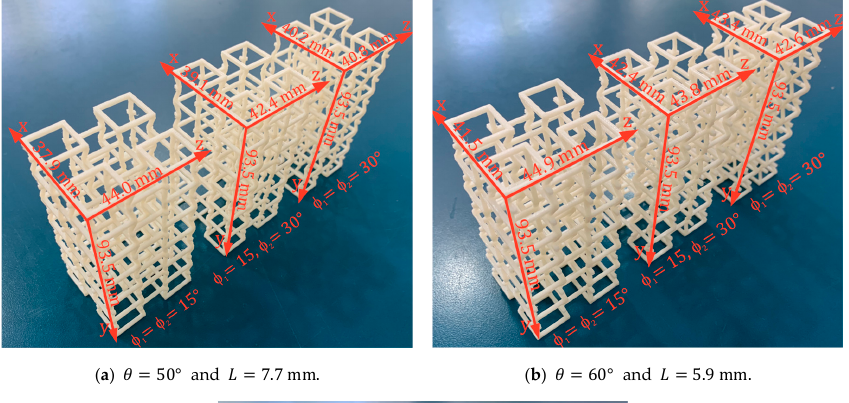
Figure 7. Experimental setup to measure the transverse deformations of structures using an image correlation system through a Basler ace Aca 1300 − 200 uc camera. Additionally, three ‐ point bending experiments were carried out at a speed of 1 𝑚𝑚 / 𝑚𝑖𝑛 . To compare the bending stiffness of each structure, the experiments were car ‐ ried out with a distance between supports equivalent to the length of 4 ‐ unit cells. To study the mechanical behavior that this new structure can experience, three groups of macro ‐ structures of 24 ‐ unit cells were manufactured (cid:4666) 2 (cid:3400) 2 (cid:3400) 6 (cid:4667) under different values for re ‐ entrant angle 𝜃 (cid:3404) (cid:4668) 50°;60°;70° (cid:4669) . Using the same geometric configurations as above, within each group, three samples were manufactured with different values for the angle of rotation ∅ (cid:3404) (cid:4668) 15°;22.5°;30° (cid:4669) . The dimensions for each macrostructure are shown in Figure 8. Polymers 2021 , 13 , x FOR PEER REVIEW 10 of 20 Figure 8.